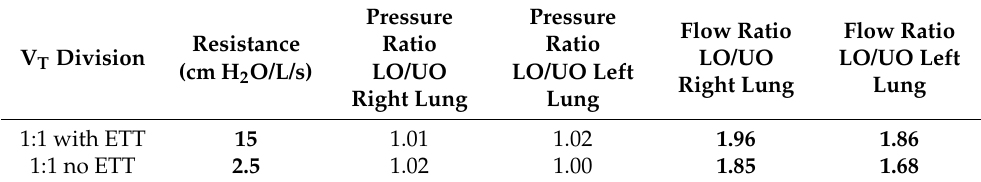
Table 3. Pressure and flow ratios for measurements with and without double-lumen ETT; LO—lower outlet (high compliance lobe), UO—upper outlet (low compliance lobe).